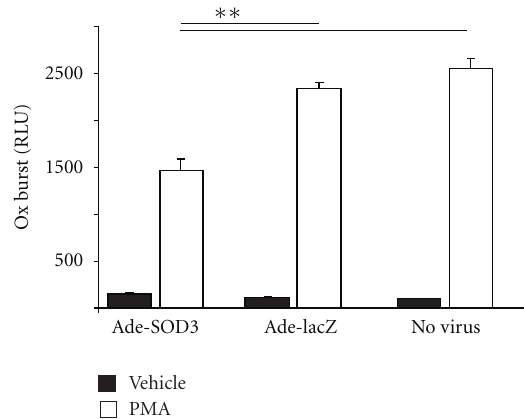
Figure 1: The amount of extracellular ROS is reduced by SOD3. Adenoviral vector coding for SOD3 (Ade-SOD3) significantly reduced the amount of extracellular ROS produced by COS cells expressing all functional components of the NOX2 complex, when compared to the Ade-LacZ control